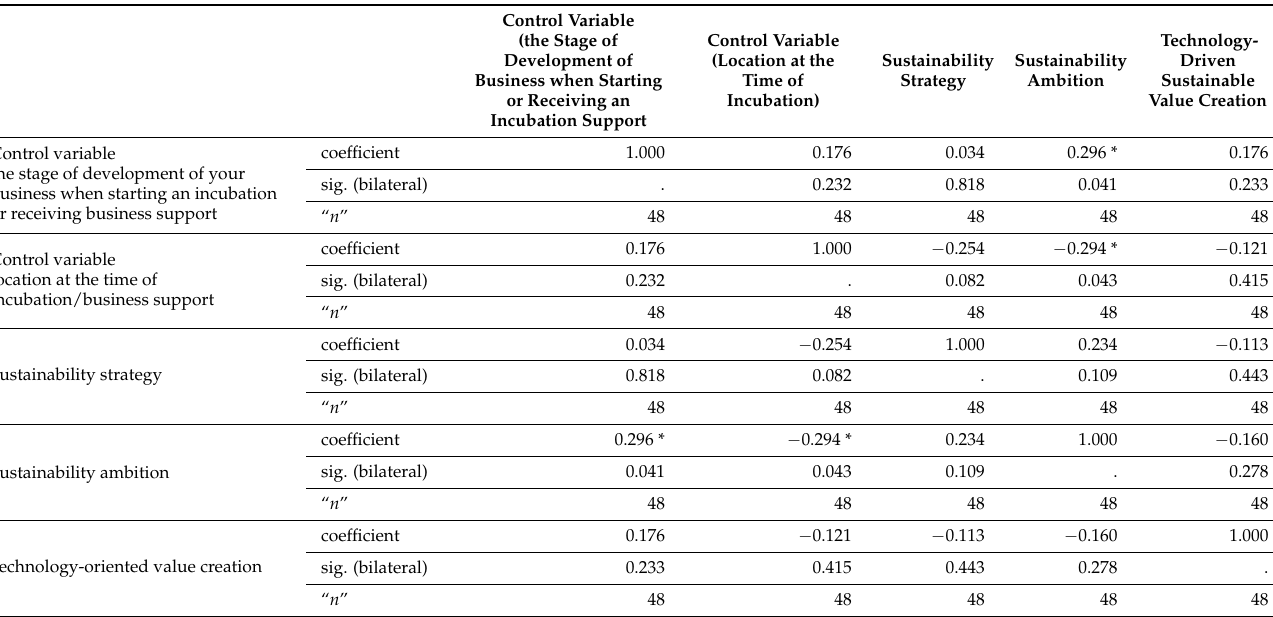
Table A6. Table of the Correlation Matrix.